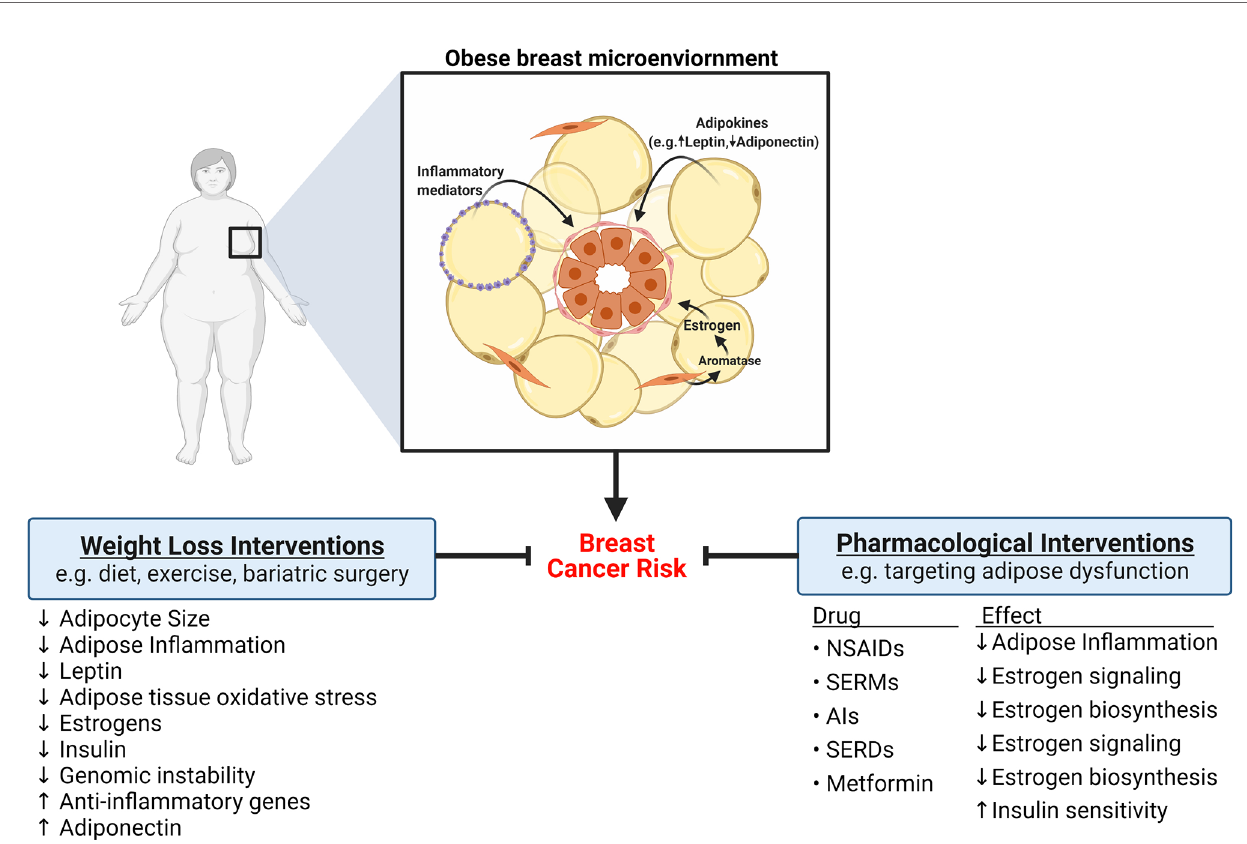
FIGURE 4 | Strategies to reduce the risk of breast cancer development in obese women. Obesity is associated with signi fi cant changes to breast adipose tissue that increase the risk of developing breast cancer, including elevation in adipose in fl ammation, altered adipokine secretion, and elevation in estrogens. Ample evidence indicates that weight loss, achieved through diet, exercise, or bariatric surgery, can reverse or diminish some obesity-induced changes to adipose tissue and consequently reduce the risk of developing breast cancer. Pharmacological interventions that target adipose dysfunction have also been shown to be ef fi cacious at reducing breast cancer risk. For example, nonsteroidal anti-in fl ammatory drugs (NSAIDs) decrease adipose in fl ammation. Drugs like selective estrogen receptor modulators (SERMS), aromatase inhibitors (AIs), and selective estrogen receptor degraders (SERDS), exert protective effects by inhibiting estrogen signaling. Metformin may also reduce risk of breast cancer through regulation of estrogen biosynthesis and improvement of insulin